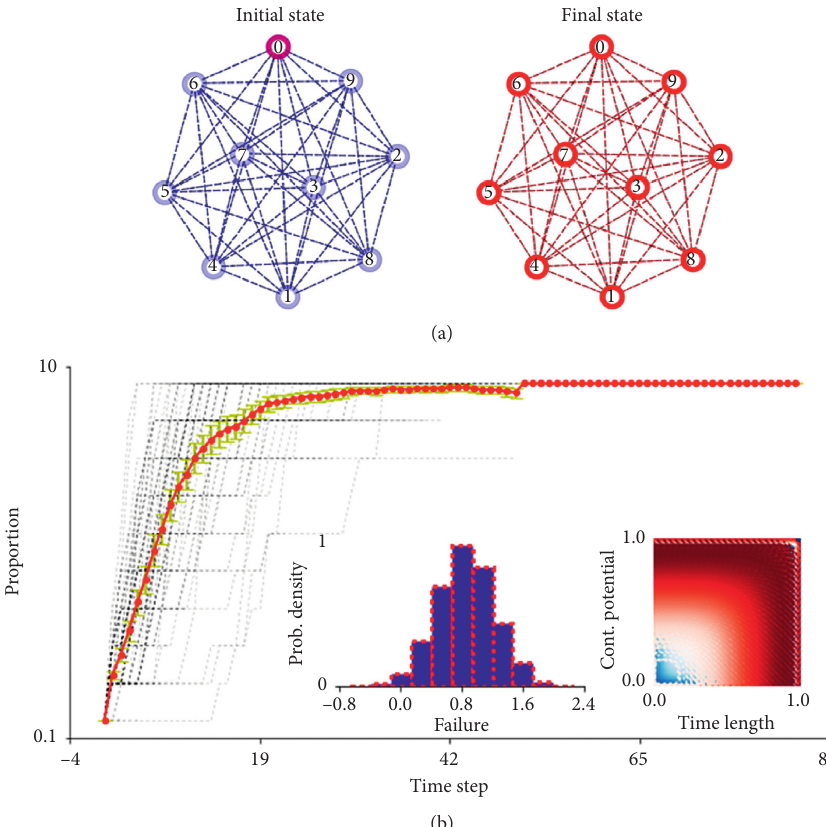
Figure 16: Visualization of the propagation of failure over time. (a) The individuals’ state from the absence of failure ( ⟶ blue) to failure ( ⟶ red). (b) The time series of the number of failures for 100 realizations (black lines) until the number of failed nodes is stabilized. The horizontal axis represents the time step, and the vertical axis represents the proportion of failed nodes (the red dots denote the averages, and the yellow error bars denote the standard deviations). The histogram in the inset on the left-hand side shows the numerical distributions (failure probabilities), and the plot in the inset on the right-hand side shows the potential of failure corresponding to the time